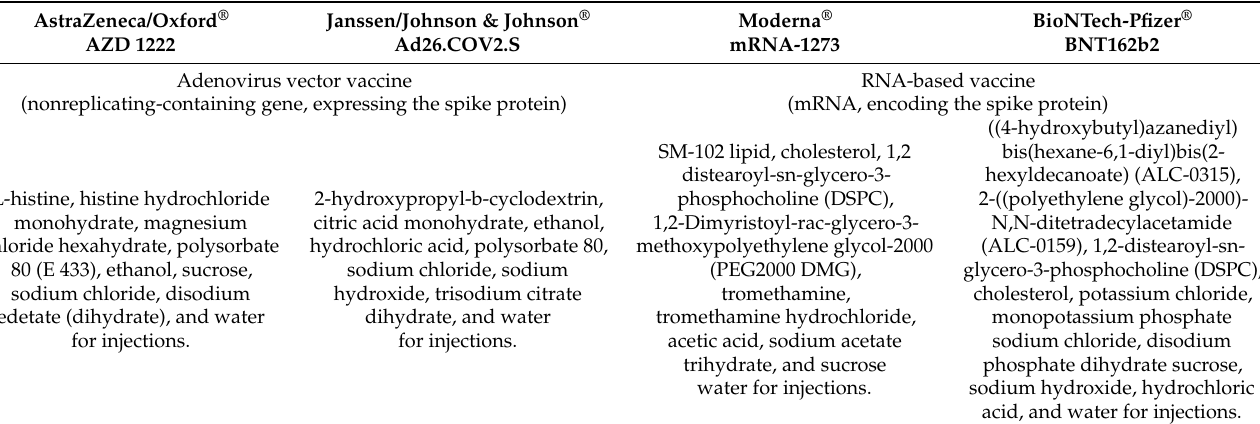
Table 1. Excipients list comparison for AstraZeneca/Oxford ® , Janssen/Johnson & Johnson ® , Moderna ® , and BioNTech-Pfizer ® vaccines. Detailed information retrieved from the product character- istic summary available on the website of the European Medicine Agency (EMA) http://www.ema. europa.eu (accessed on 13 January